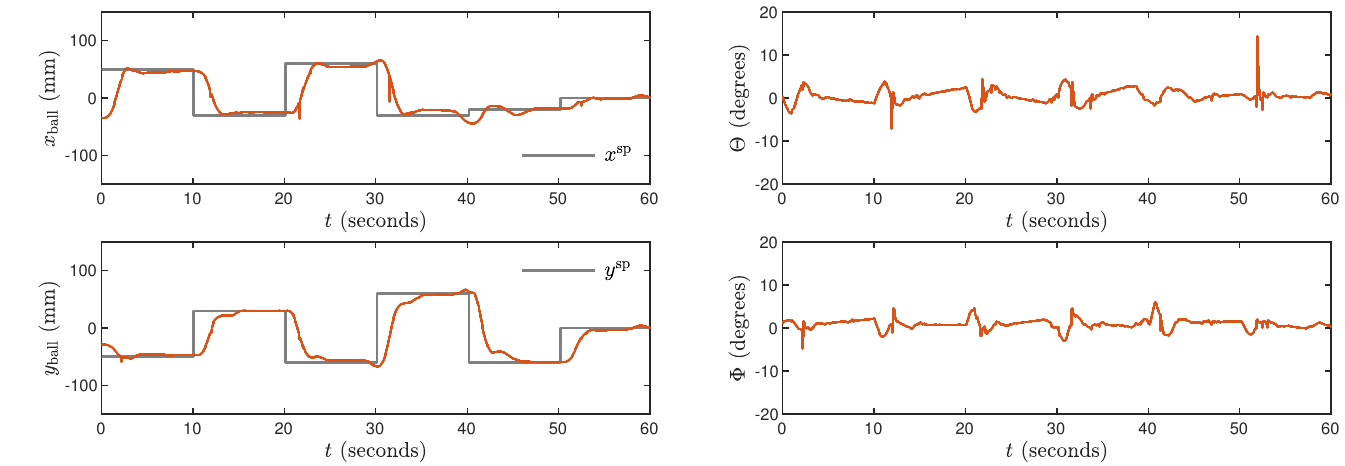
Figure 11. Experimental results of the LQR2 algorithm.